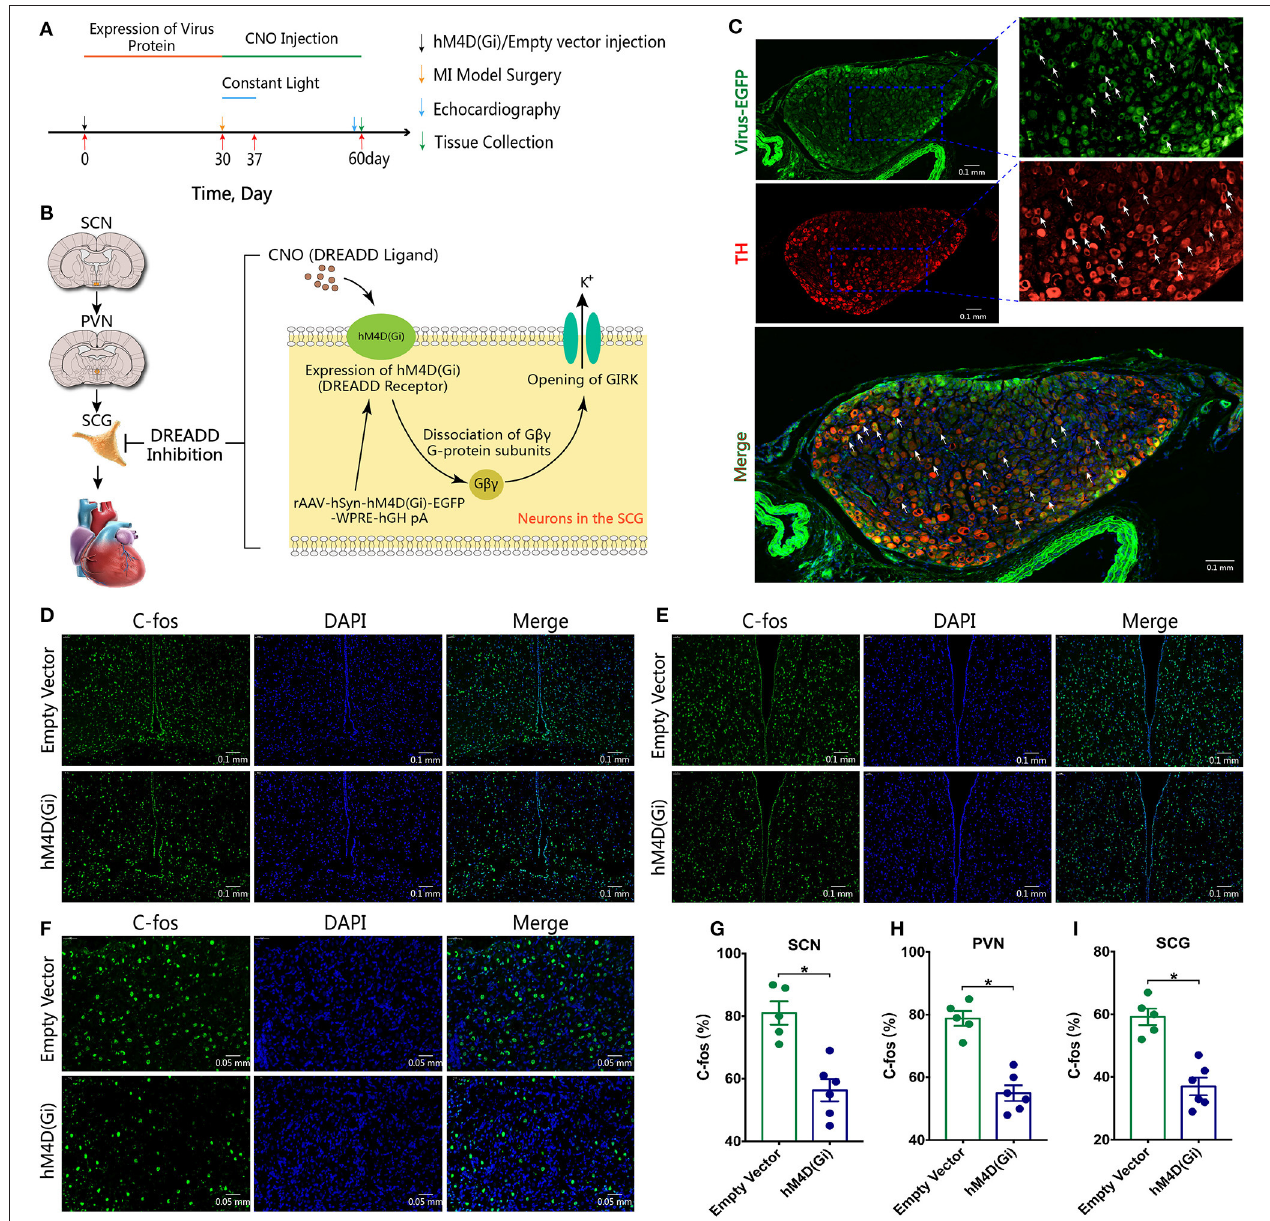
FIGURE 4 | Sympathetic ganglionic blockade by DREADD. (A) Experimental protocol of DREADD. (B) Rationale of DREADD. (C) virus-EGFP (green) and TH (red). (D–I) Expression levels of c-Fos at the SCN, PVN, and SCG. CNO, Clozapine N-oxide; GIRKs, G-protein sensitive inwardly rectifying potassium channels; p * < 0.05.